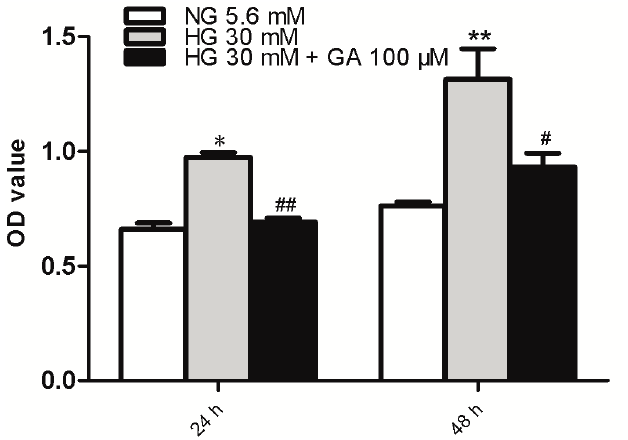
Figure 1. Proliferation assay. NRK-52E cells were treated with high glucose (HG) with or without glycyrrhizic acid (GA) as indicated for 24 or 48 h, followed by MTT (methylthiazoletetrazolium) analyses. Cells receiving normal glucose (NG) were included as control. n = 3. * p < 0.05 vs. NG; ** p < 0.01 vs. NG; # p < 0.05 vs. HG; ## p < 0.01 vs.